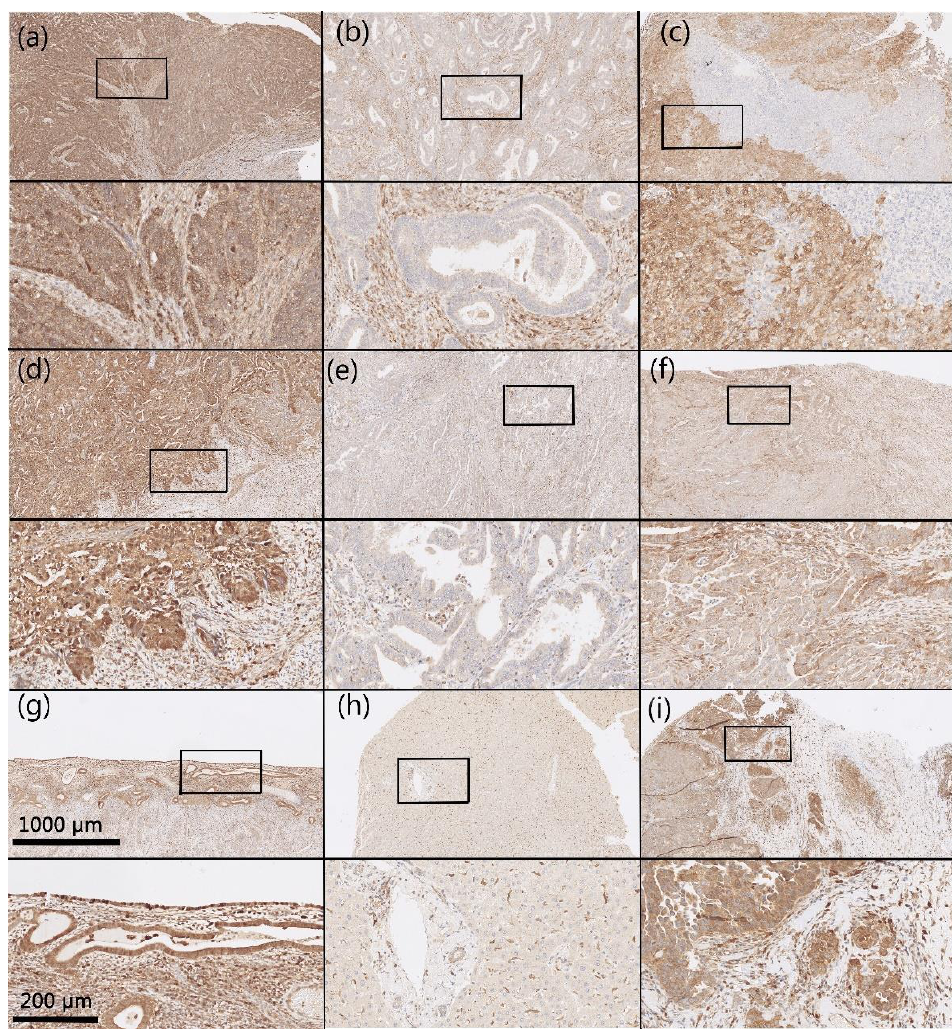
Figure 2. Representative immunohistochemical staining for AKR1B1. Samples of endometrioid EC ( a – c ), serous EC ( d – f ), non-neoplastic endometrial tissue ( g ), control liver tissue ( h ) and control high-grade serous ovarian cancer ( i ). Upper half of panels: 50× magnification; lower half of panels: the framed area from the upper half of the panel (200× magnification). Hematoxylin and eosin (HE) stained sections (Figure S1).